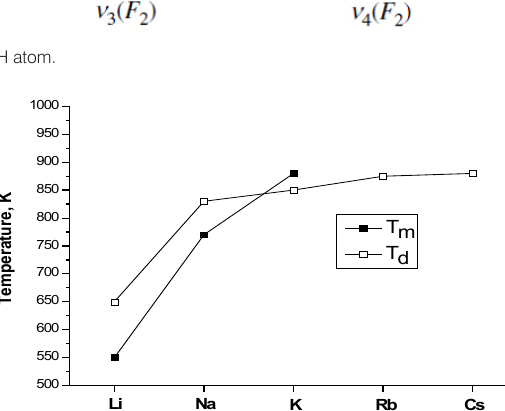
Figure 2. Dependence of melting and decomposition temperatures